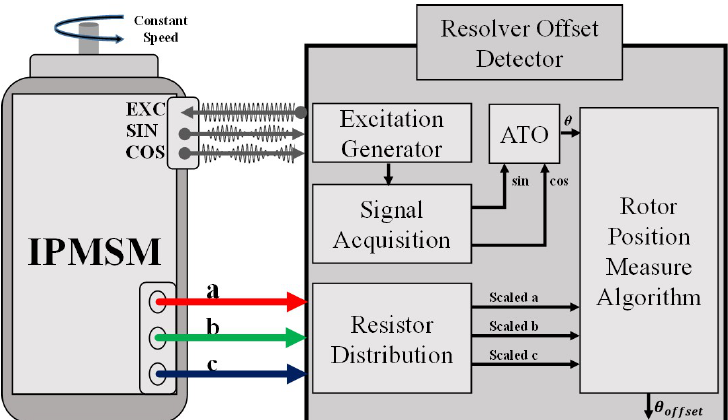
Figure 7. Resolver offset measure system.